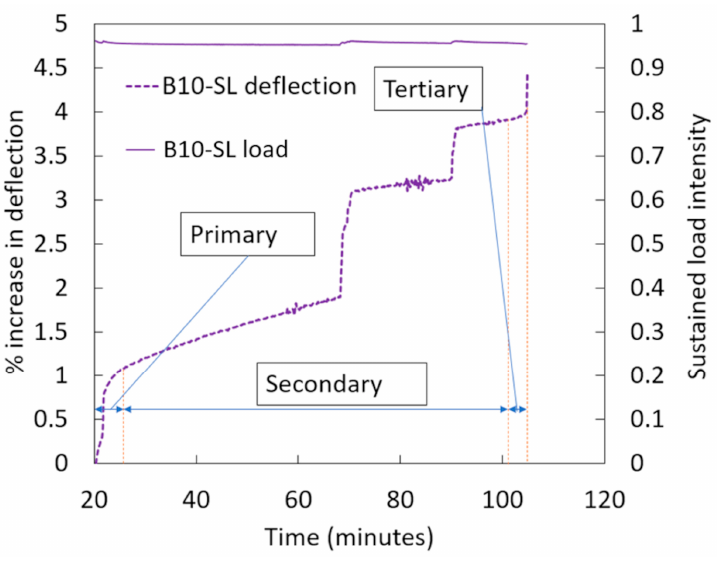
Figure 18. Percent increase in deflection with time for specimen B10-SL.